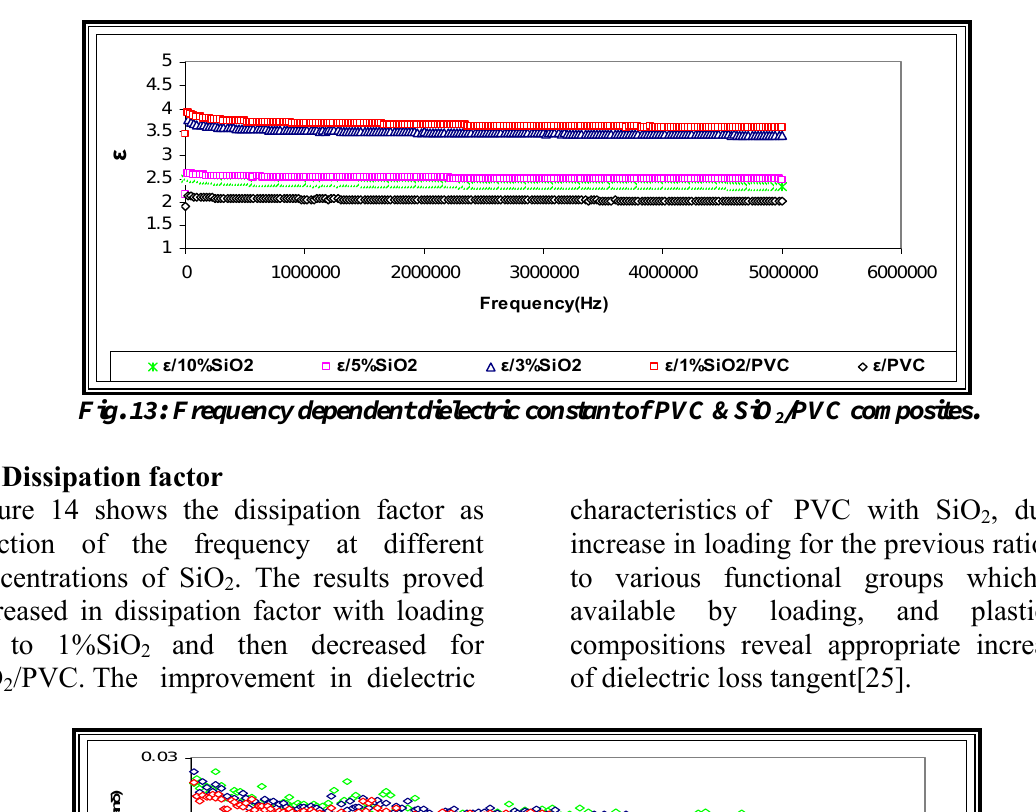
/PVC composites. 2